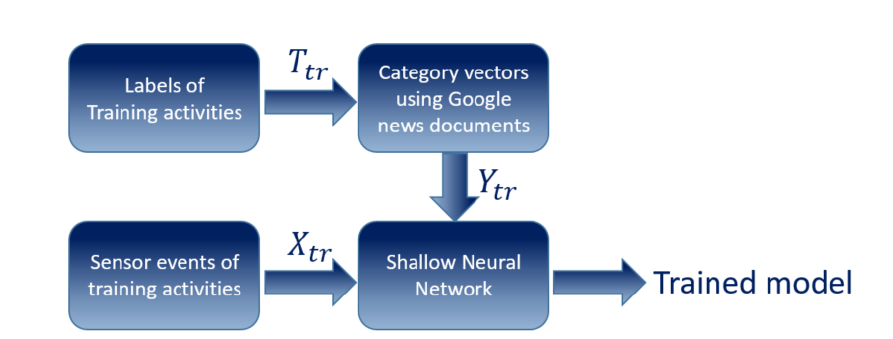
Figure 2. Training phase, where T tr are the training class category labels, X tr are the sensor readings of training activities, and Y tr are the corresponding L-dimensional semantic representation vectors of the training labels.